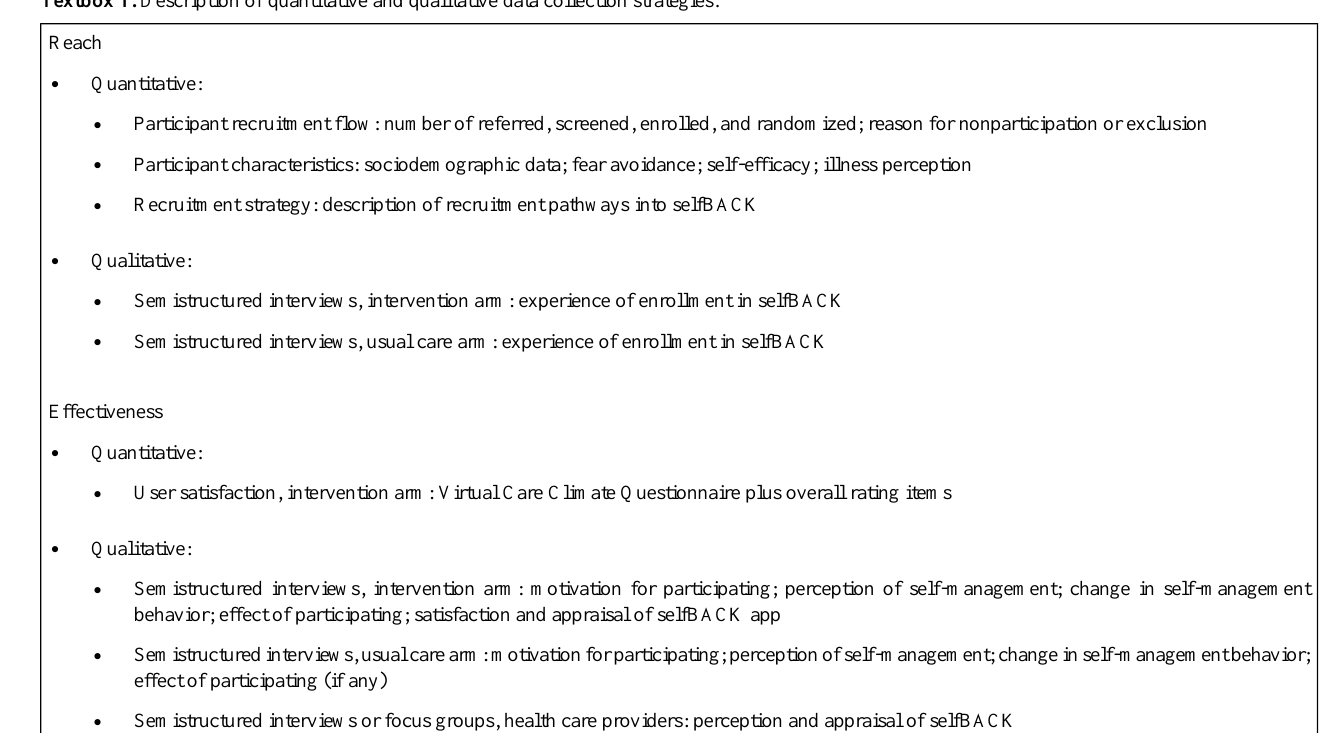
Textbox 1. Description of quantitative and qualitative data collection